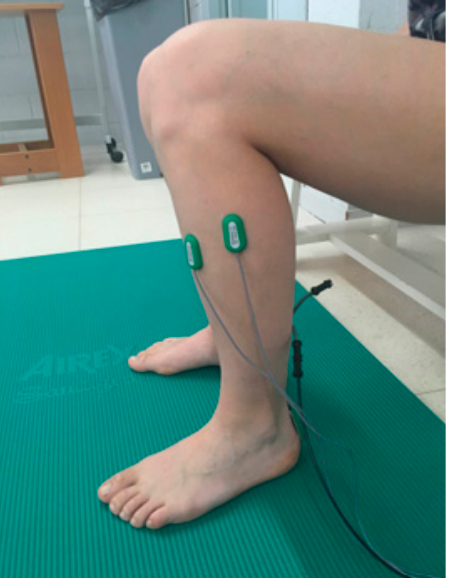
Figure 1. Surface electrode placement.